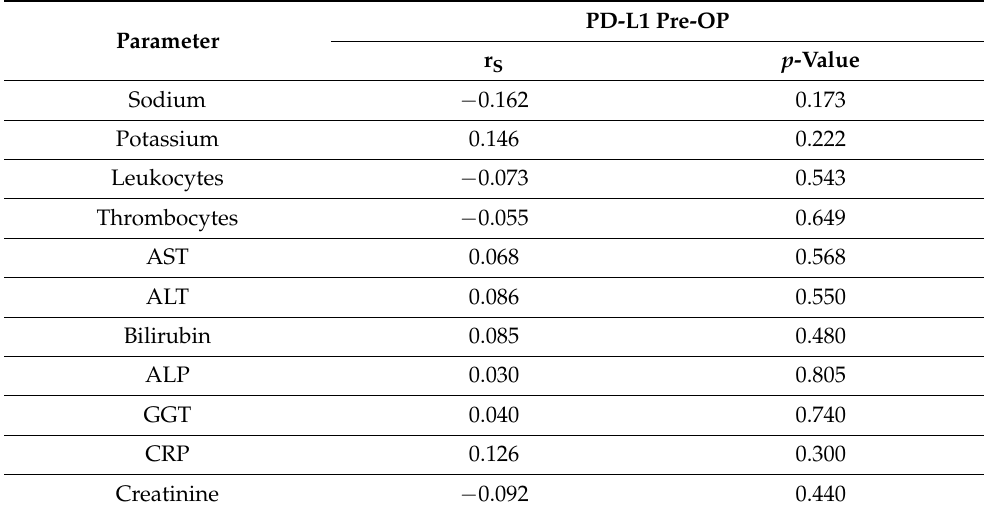
Table 2. Correlation analyses between preoperative PD-L1 and routine laboratory markers.